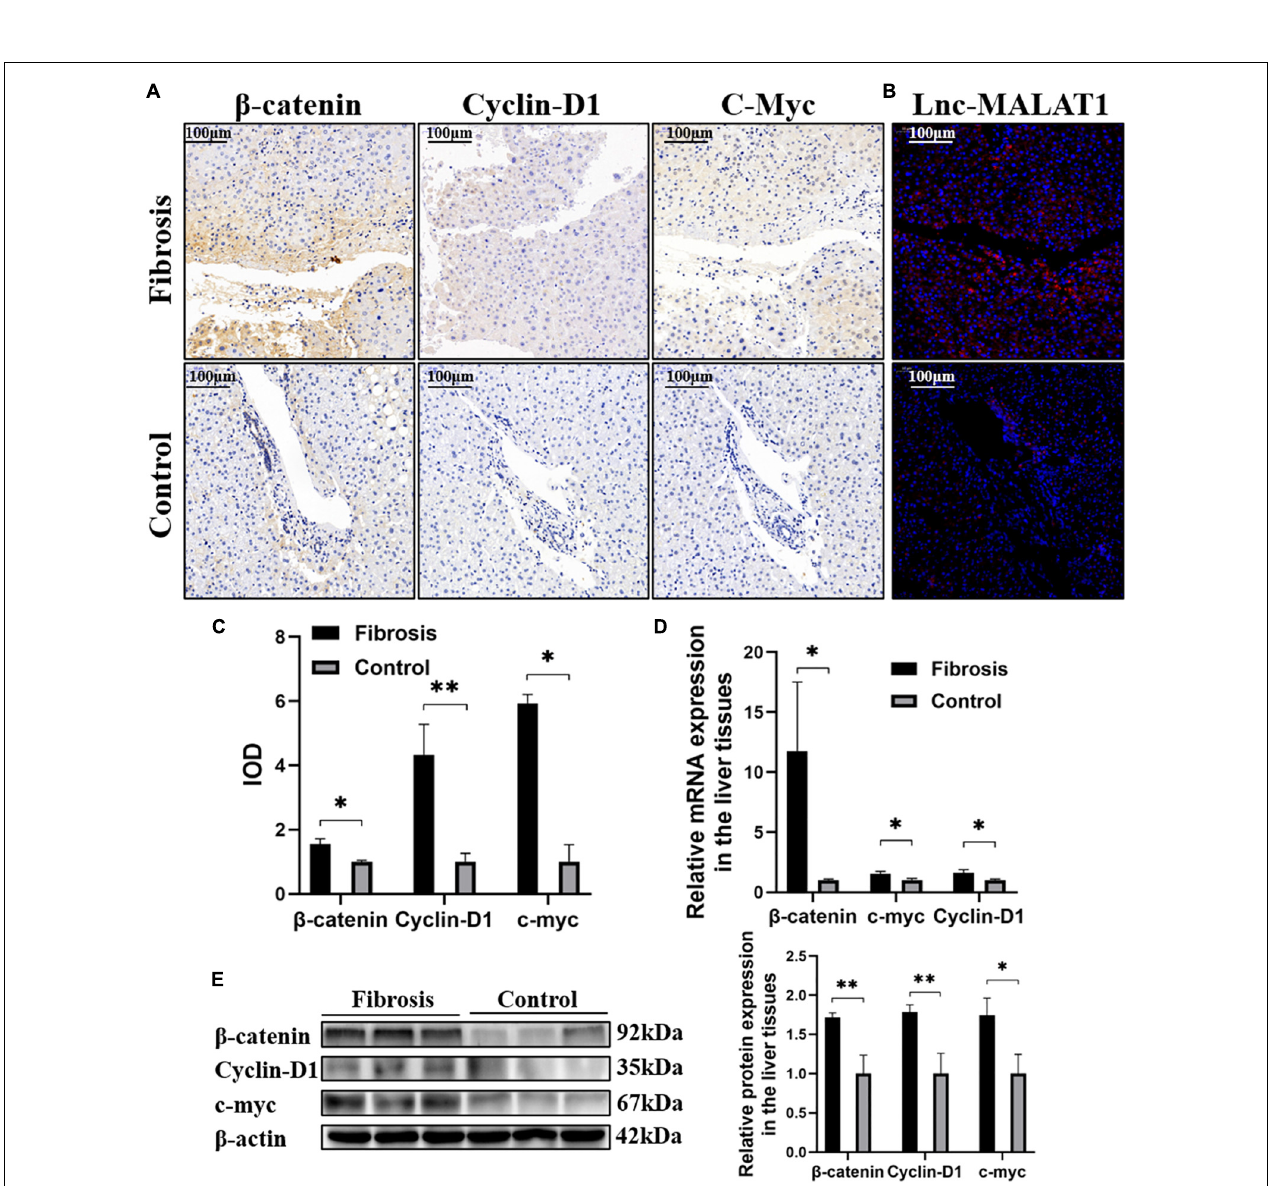
FIGURE 2 | Correlation of enhanced β -catenin signaling with up-regulated Lnc-MALAT1 expression in the fibrotic liver tissues. The liver tissue specimens from the high fibrosis group and control group ( n = 6 in each group) were used for IHC, FISH and qRT-PCR analyses. (A) Representative images of IHC detection of the expression of β -catenin, cyclin-D1, and c-myc. (B) Representative image of FISH for Lnc-MALAT1 in the consecutive tissue slides. (C) IOD values of the expression of β -catenin, cyclin-D1, and c-myc measured by the software of Image-pro plus 6.0. (D) The mRNA expression of β -catenin, Cyclin-D1 and c-myc detected by qRT-PCR. (E) Western blot analysis of the protein expression of β -catenin, Cyclin-D1, and c-myc (three specimens from each group were detected, and relative expression intensities were expressed on the right). ∗ , ∗∗ , and ∗∗∗ represent p- values less than 0.05, 0.01, and 0.001, respectively.